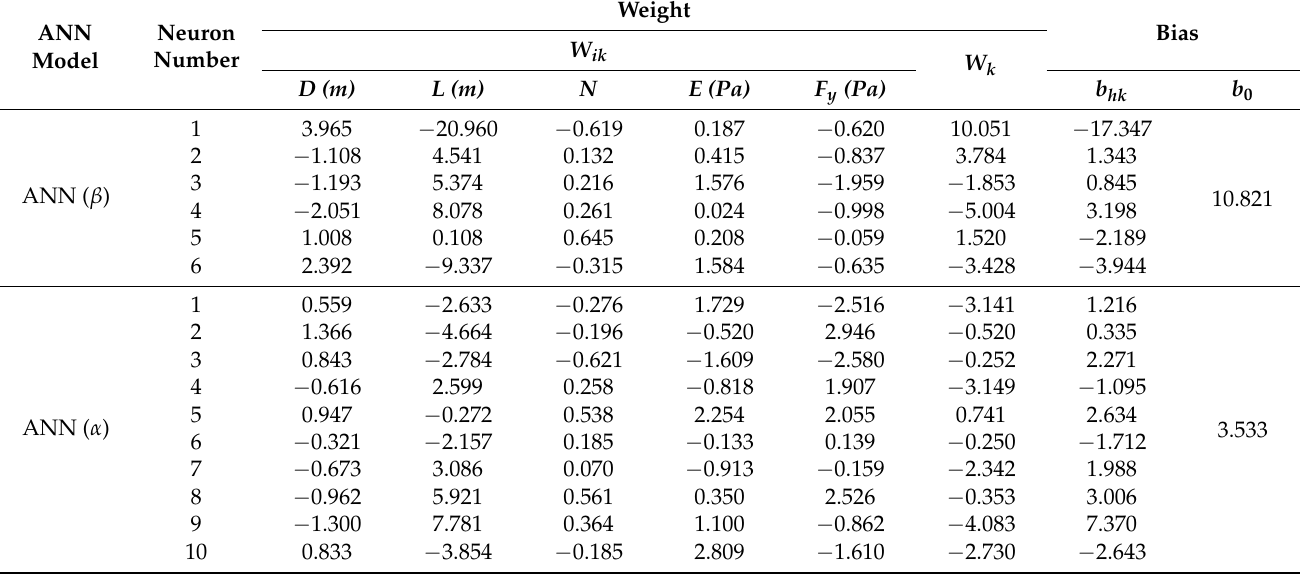
Table 5. The weights and bias of the β and α using ANN ( β ) and ANN ( α